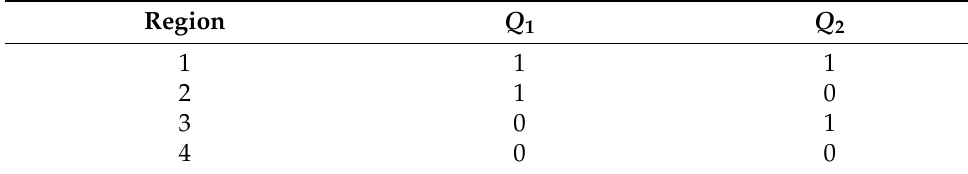
Figure 8. Three sawtooth waveforms for the proposed PWM strategy. Table 3. Switching regions based on proposed PWM